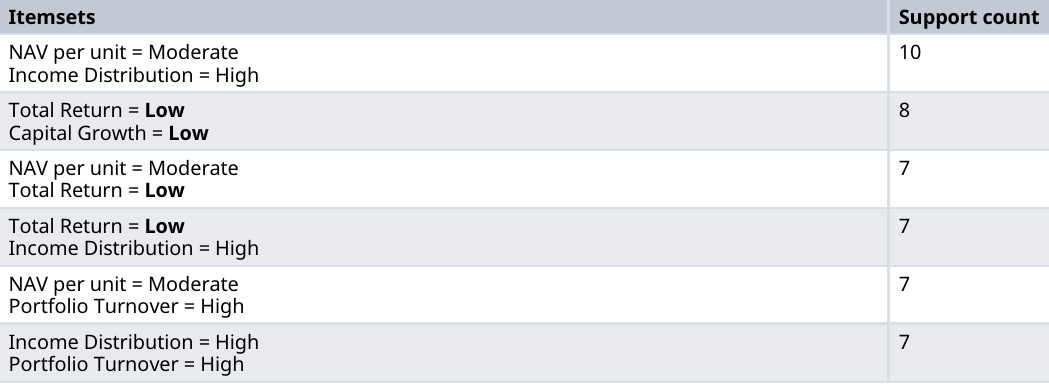
Table 5. Six frequent 2-itemsets were produced after analysing Cluster 5 with the ARM. Itemsets